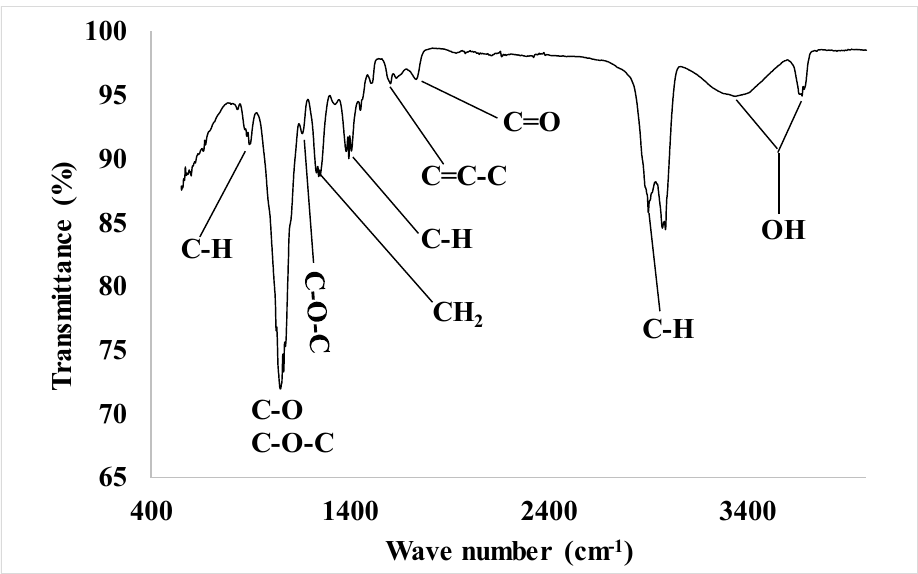
Figure 6. Infrared spectrum of sugarcane bagasse.